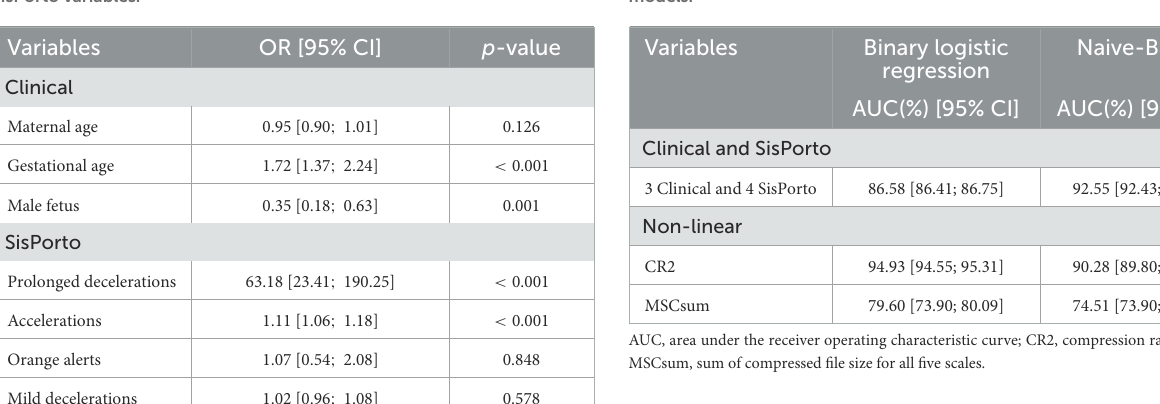
TABLE 3 Odds ratios obtained from the multivariate logistic regression model for the prediction of perinatal asphyxia based on clinical and SisPorto variables.